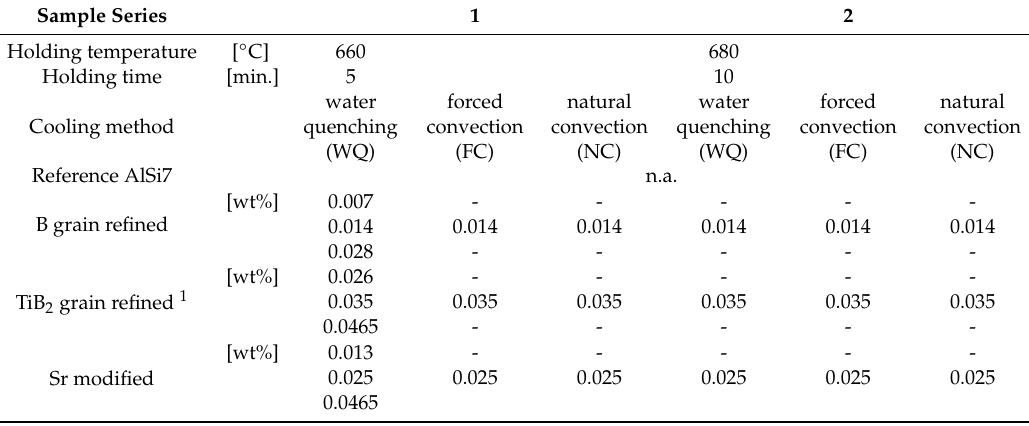
Table 2. Overview of powder compact sample series for evaluation of grain refinement and modification of the Al-Si eutectic.